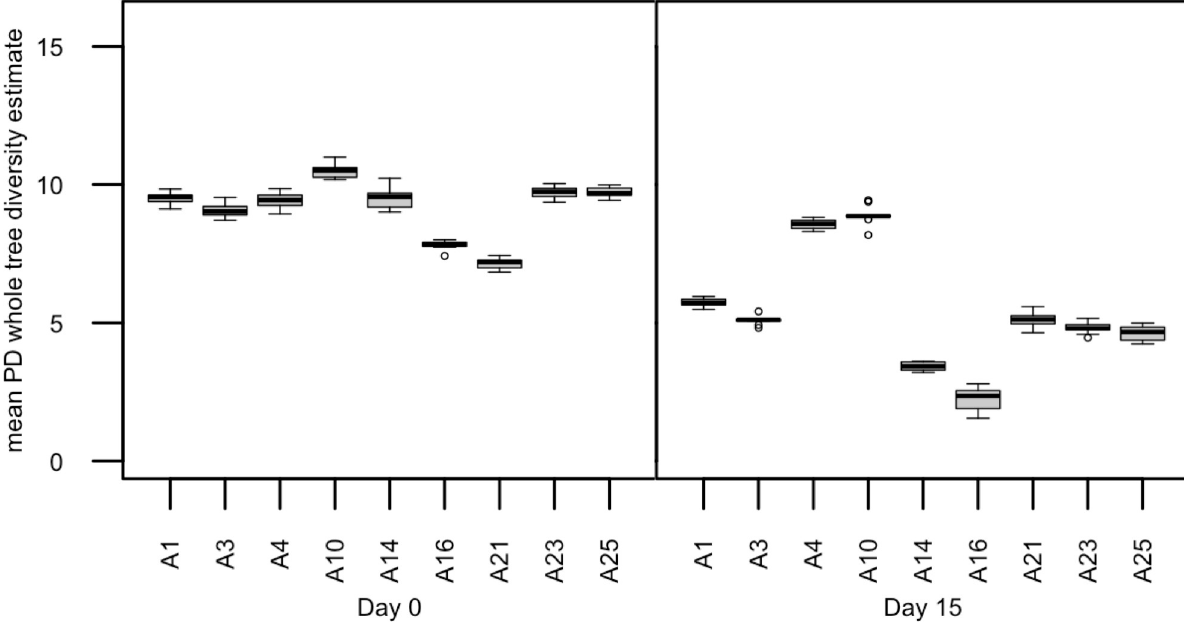
Fig 2. Comparisons of PD whole tree alpha diversity of TNT dosed male anoles’ fecal microbiome at day 0 and day 15. https://doi.org/10.1371/journal.pone.0208281.g002 PLOS ONE | https://doi.org/10.1371/journal.pone.0208281 December6,